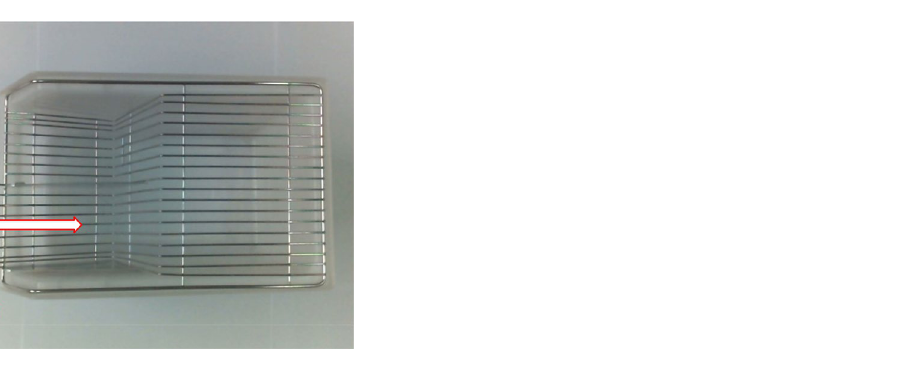
Figure 9. Original feeding box